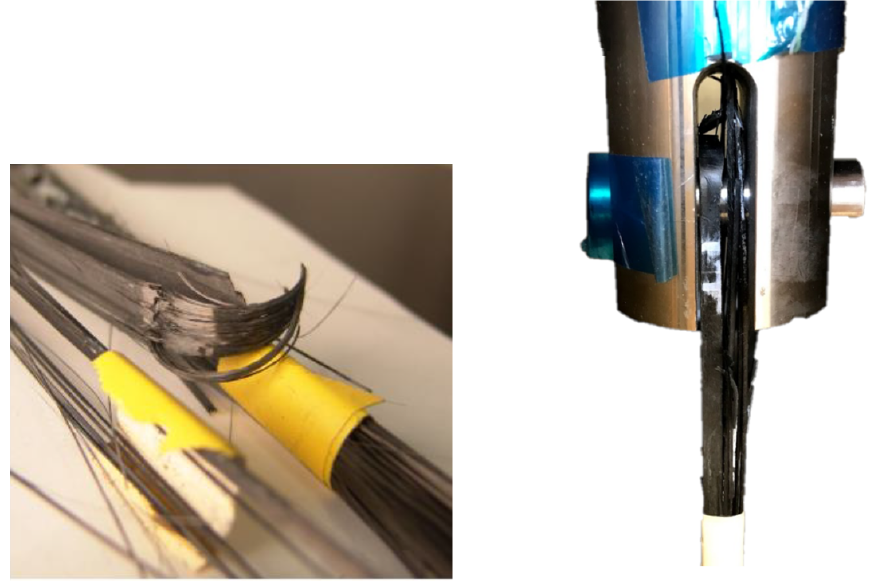
Figure 9. Typical tensile failures of CFRP straps starting at the onset of curvature (vertex).